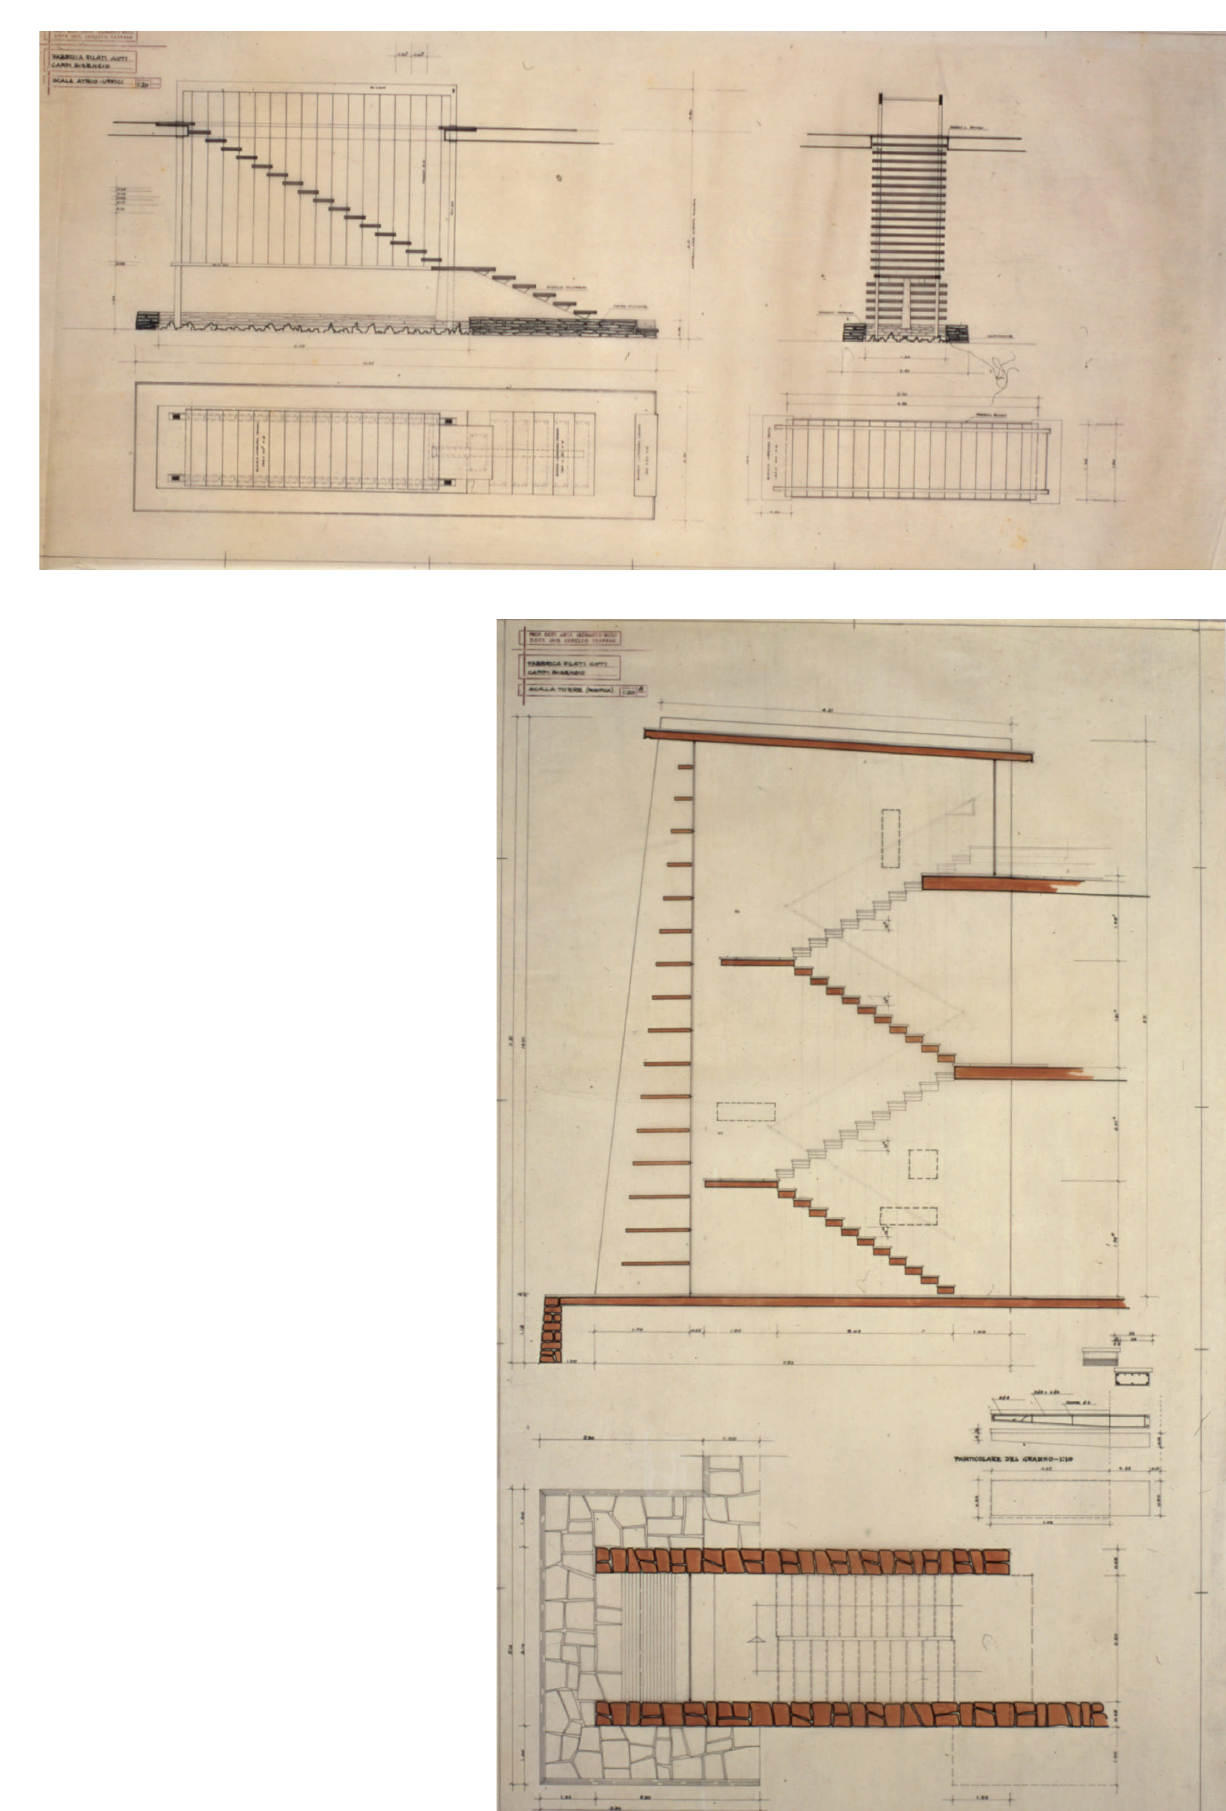
IMG.4-5: images of the panels Ricci elaborated for the exhi - bition “Aspetti dell’Arte Con-